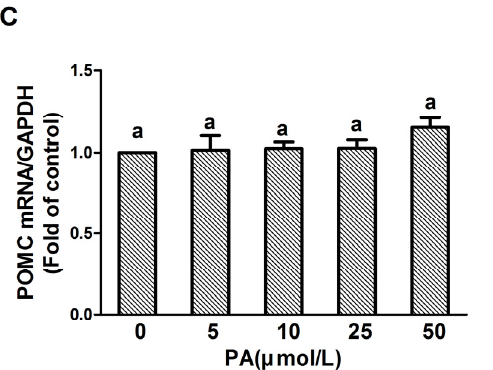
Figure 2. Dose-dependent effect of PA on NPY, AgRP, and POMC expression in N1E-115 cells. Quantitative real-time PCR amplification of NPY, AgRP, and POMC performed with RNA extracted from N1E-115 cells following treatment with differing concentrations of PA for 20 min ( A – C ), respectively. Quantified mRNA levels were normalized to GAPDH and presented relative to 0 µ mol/L PA for 20 min. Data are expressed as means ± SEM of three different experiments. Groups sharing different letters above the bars indicate statistically significant differences ( p < 0.05), while those denoted by the same letters are insignificant ( A – C ). PA: palmitic acid group.